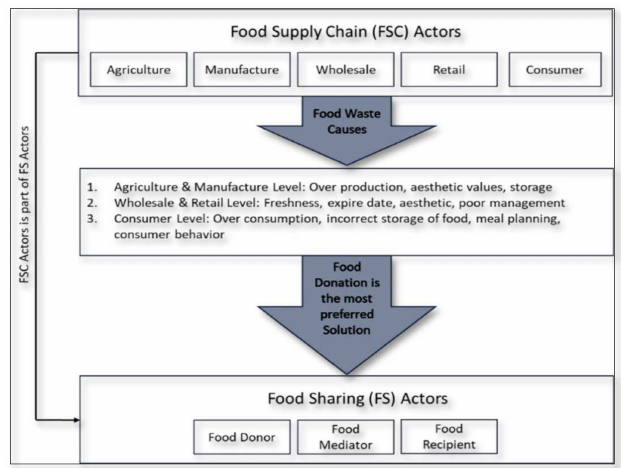
Figure 5. The relationship between FSC actors and FS